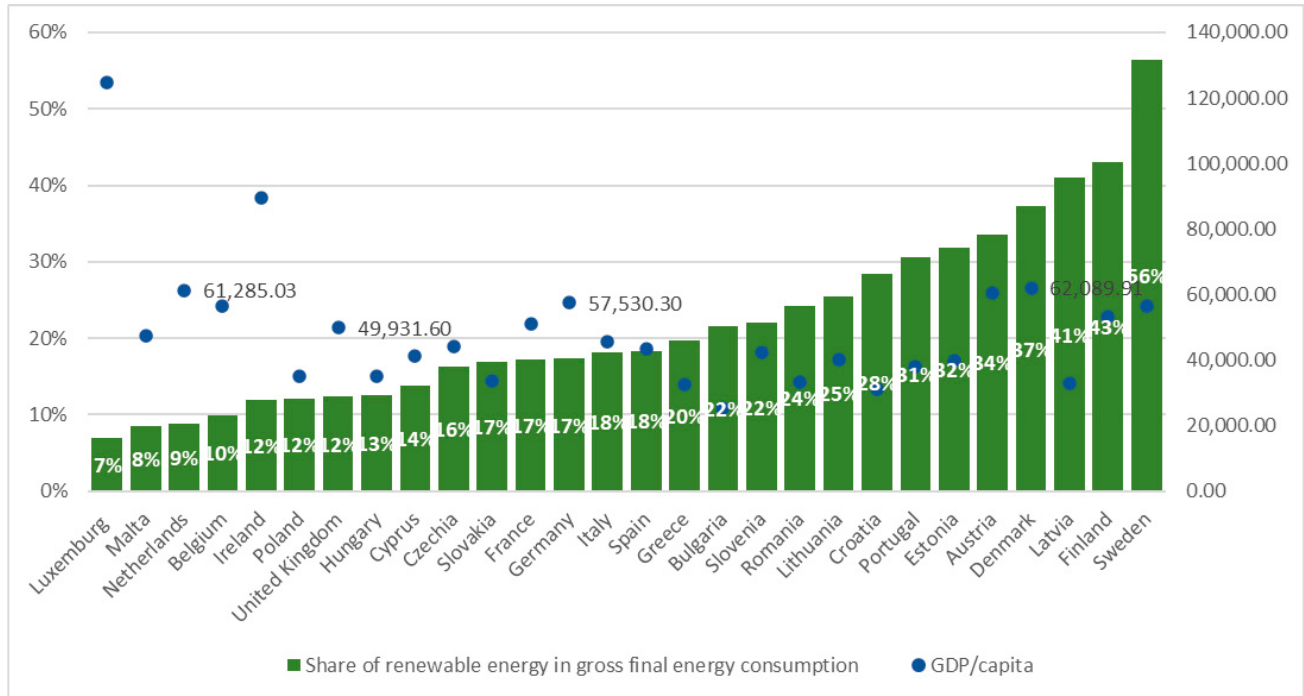
Figure 2. Share of renewable energy and GDP/capita.